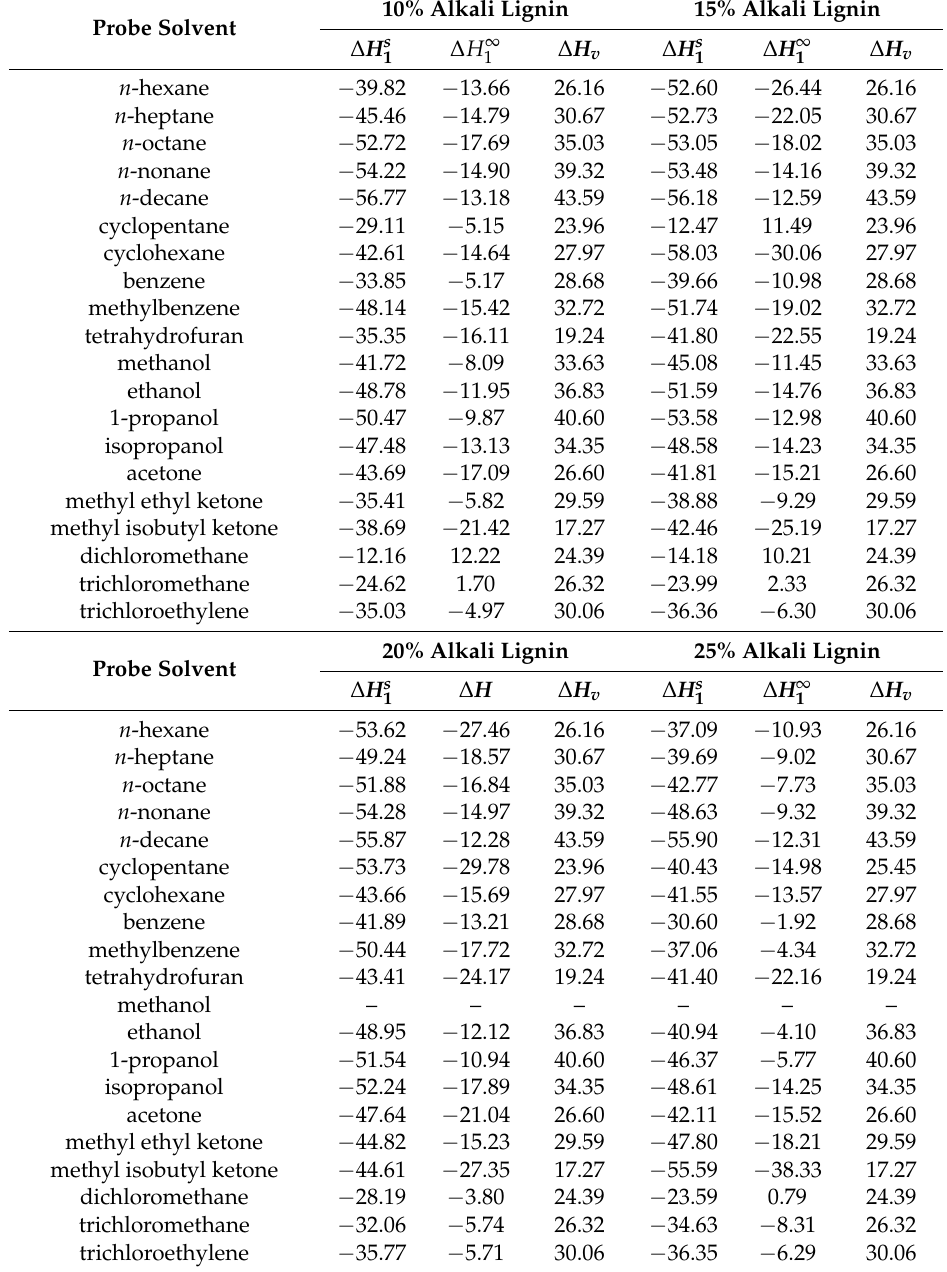
Table A2. Thermodynamic parameters of the probe solvents